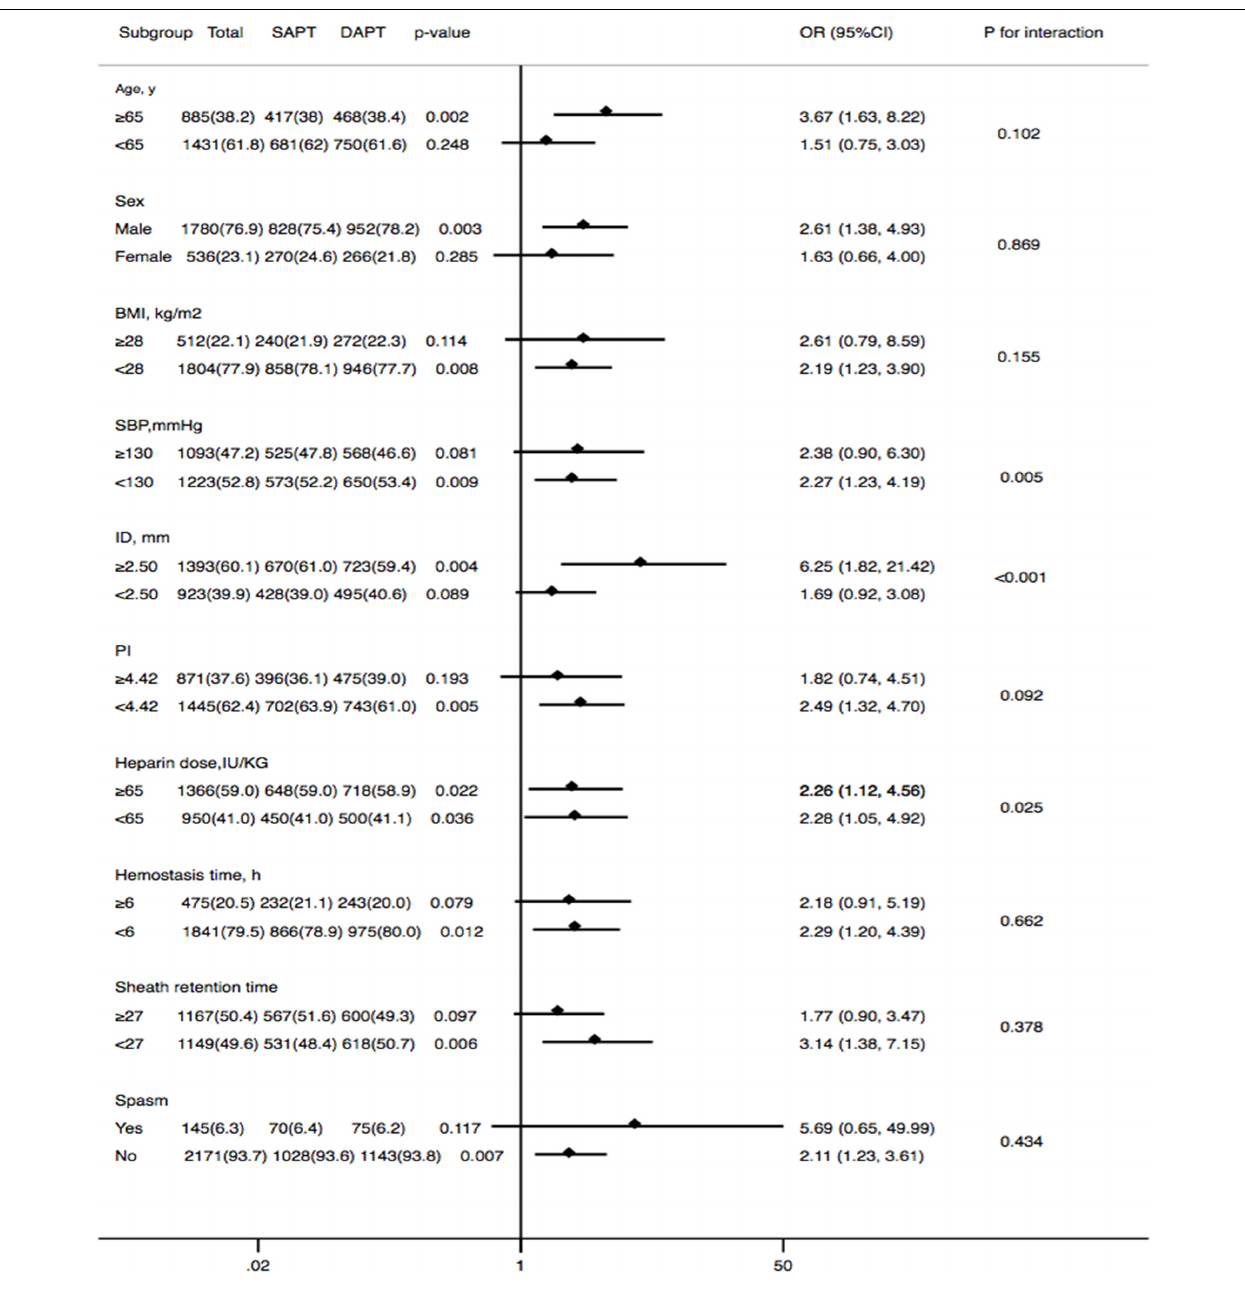
FIGURE 3 | Forest plot investigating the association between DAPT and the prevalence of RAO at 30 days after the TRCA in different subgroups. DAPT, dual-antiplatelet therapy; RAO, radial artery occlusion; BMI, body mass index; SBP, systolic blood pressure; ID, inner diameter; PI, pulsatility